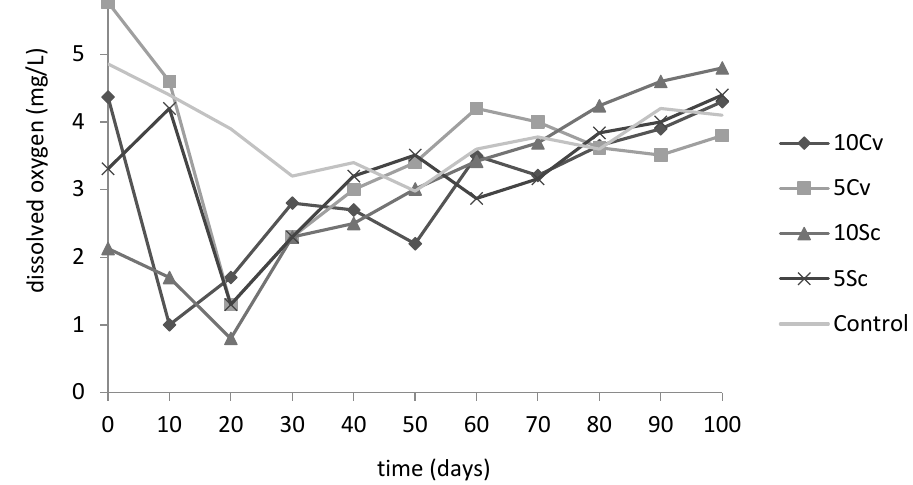
Figure 1. Oxygen concentration observed during the batch culture cultivation of microalgae.